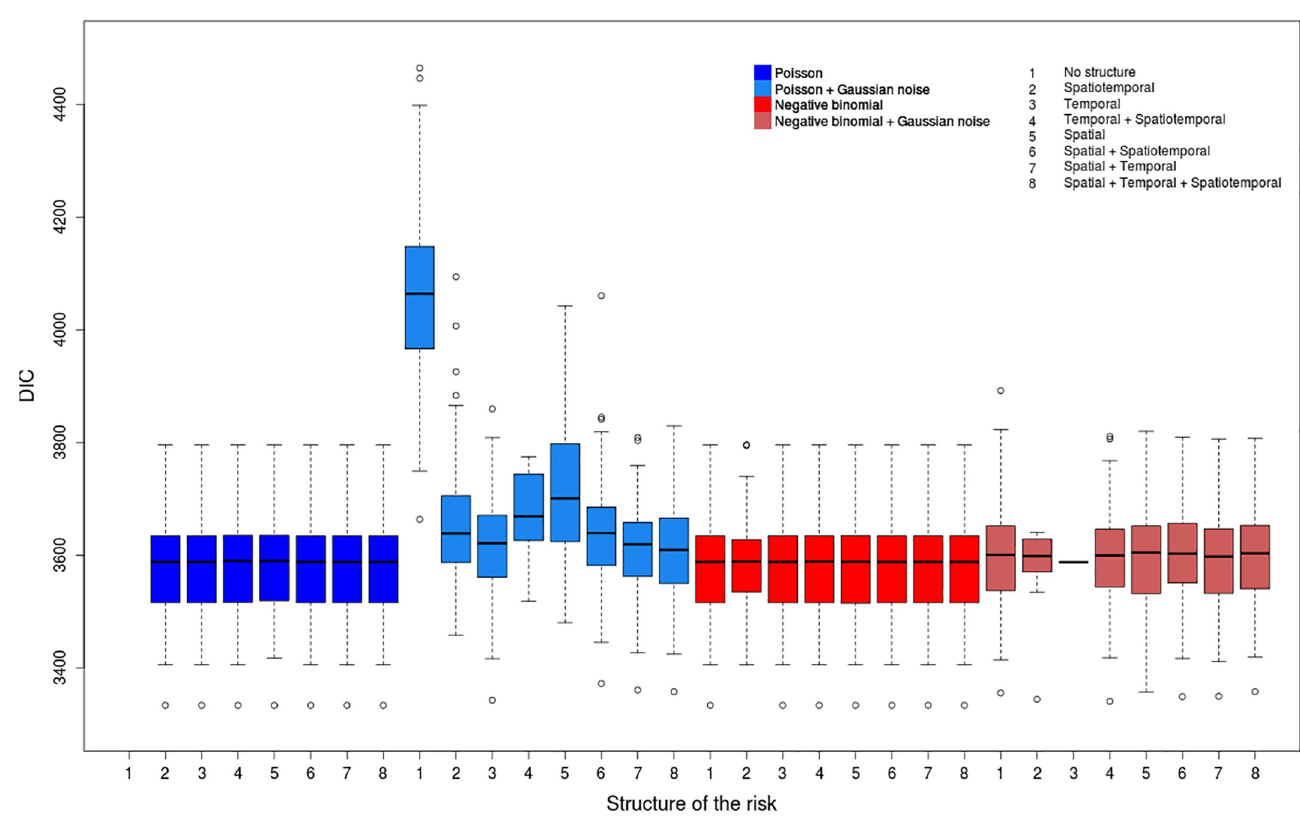
Fig 6. Distribution of DIC values for the scenario